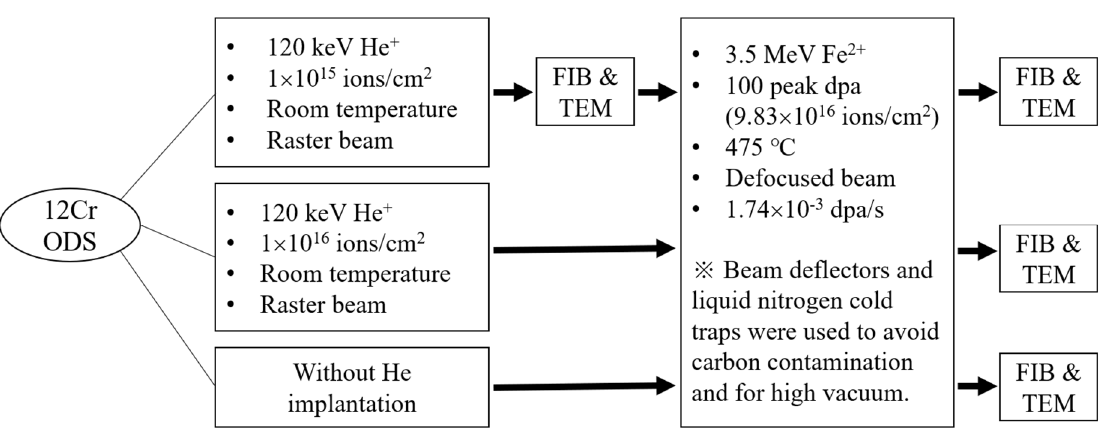
Figure 1. Diagram of experimental steps.